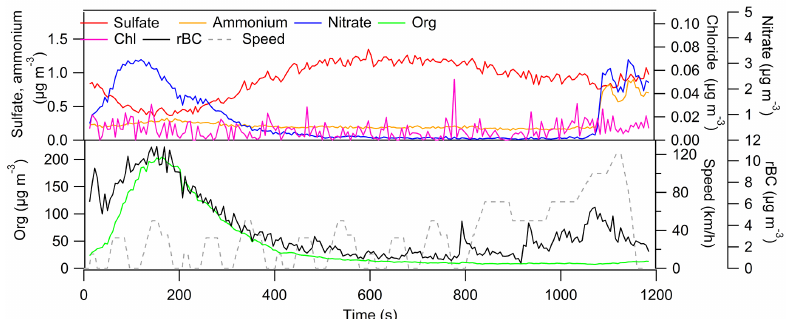
Figure 6. Temporal behavior of rBC, organics, SO 4 , NO 3 , NH 4 and Cl concentrations measured by the SP-AMS downstream of the PAM chamber during the NEDC test cycle.